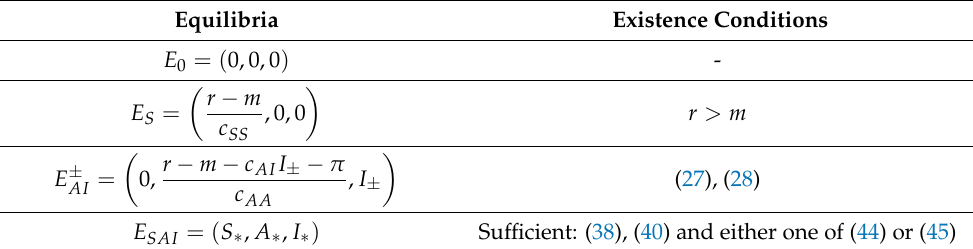
Table 4. Summary of equilibria and their feasibility for model (23).